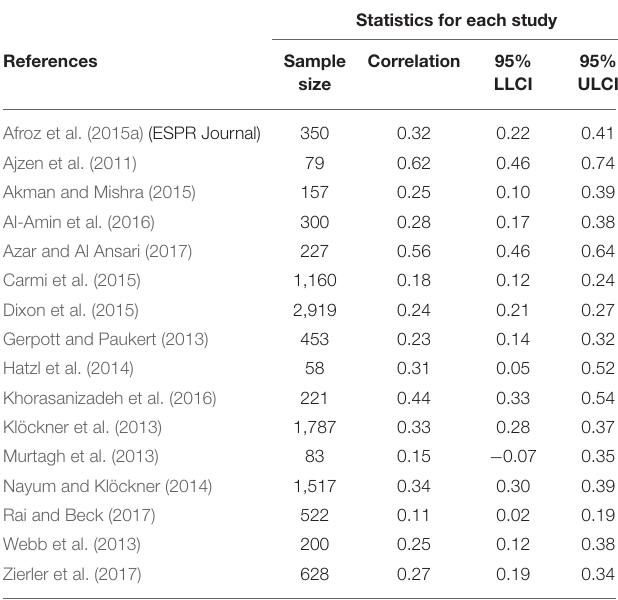
TABLE 2 | Summary of ES of the association between intentions to adopt energy saving solutions and energy saving behavior. Statistics for each